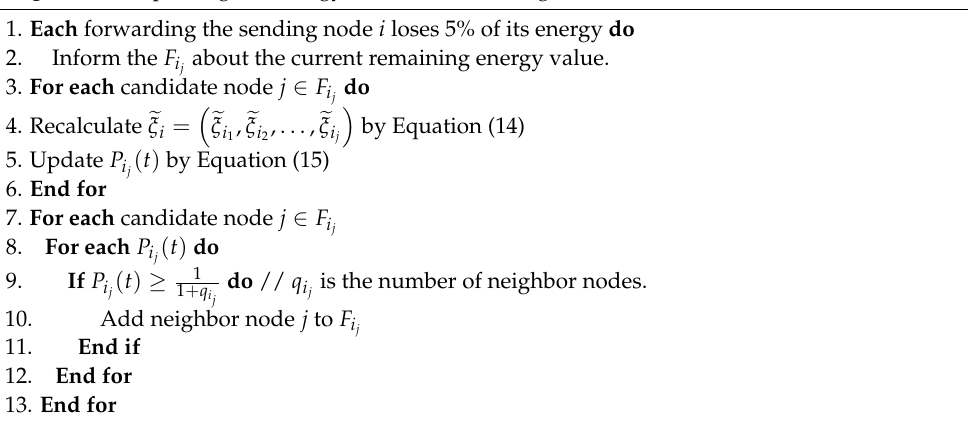
Algorithm 1 Updating the Energy Distribution of Neighbor